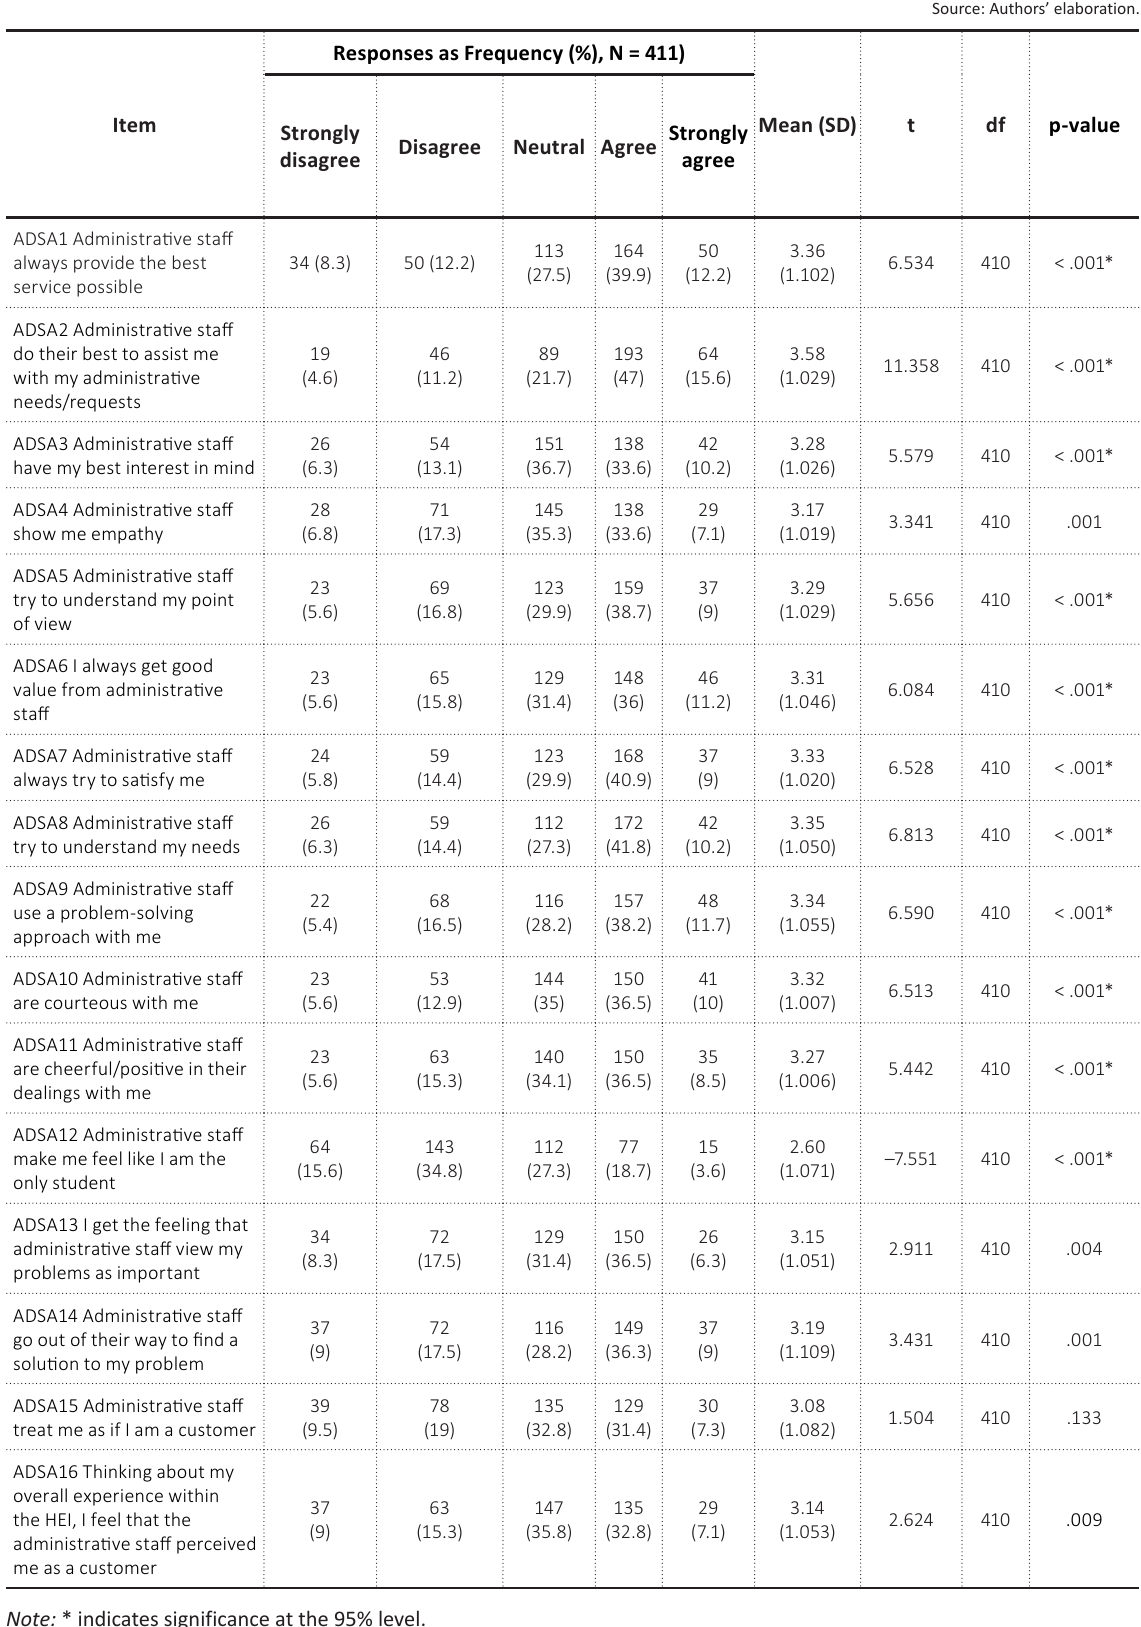
Table 3. Students’ perception of the attitude of administrative staff